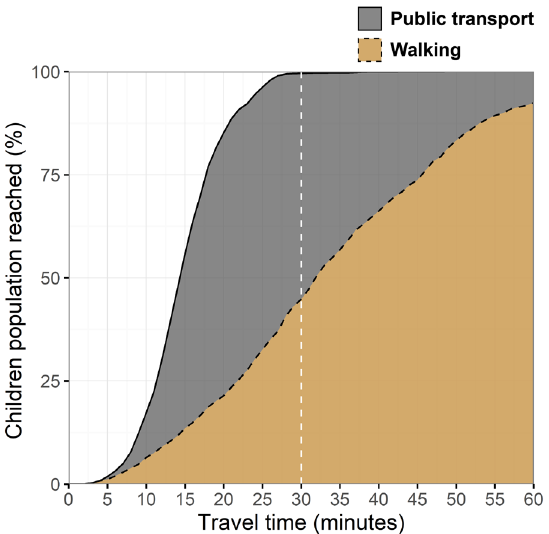
Fig. 8. Travel time accessibility to mechanically frozen ice skating fields for children and adolescents in Helsinki. The threshold of 30 minutes is shown with a white dashed